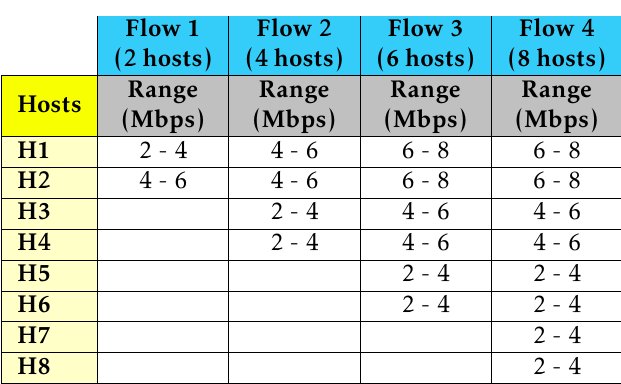
Figure 5. Test network architecture - Mininet